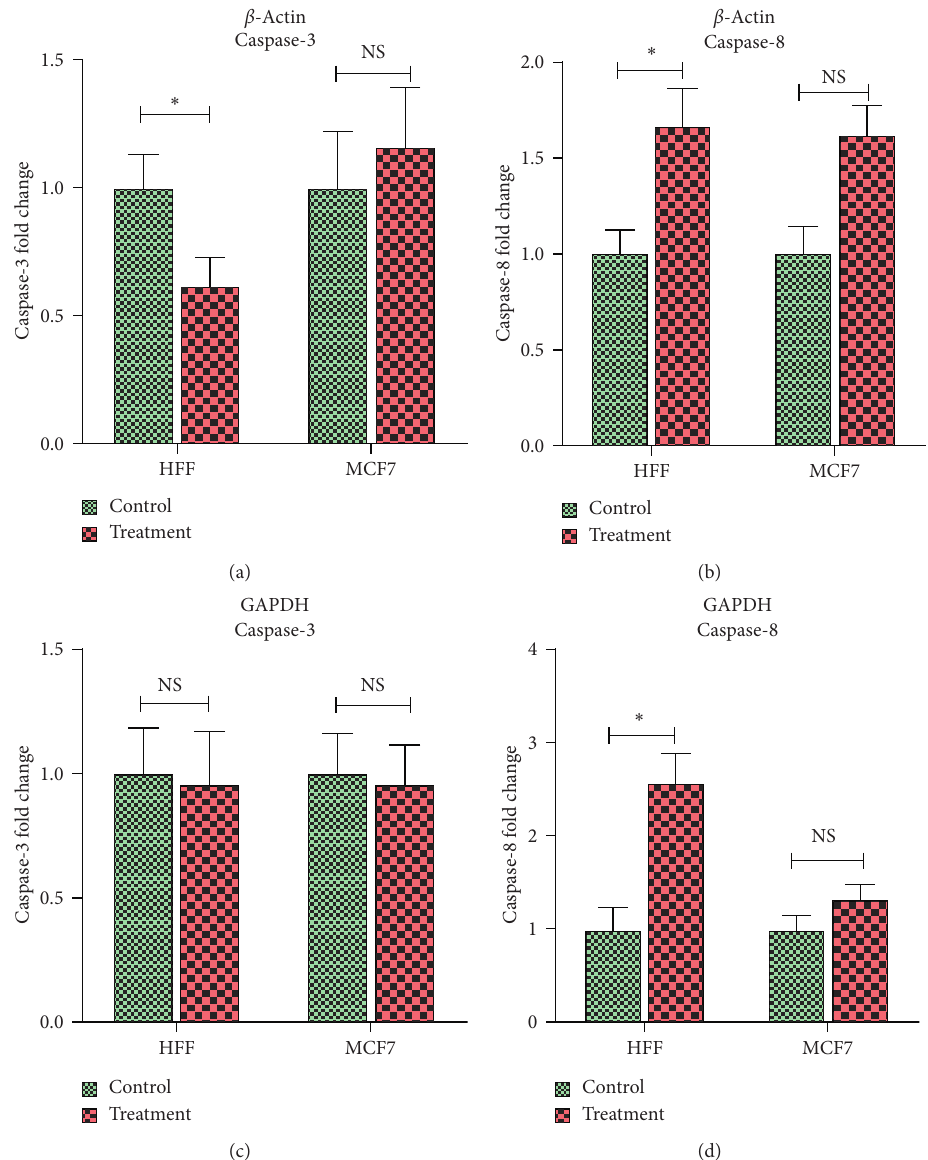
Figure 7: Caspase-3 and Caspase-8 gene expression in MCF7 breast cancer and HFF cells after 24 h incubation with their IC NP concentrations. The Tukey comparison of the fold change values was performed for the caspase-3 and caspase-8 gene expression in ZnO- NP-treated and untreated cells based on β -actin and GAPDH internal controls. In the diagram analyses, the control group was used as a reference for calculating fold change. ∗ refers to the significance, p < 0 .